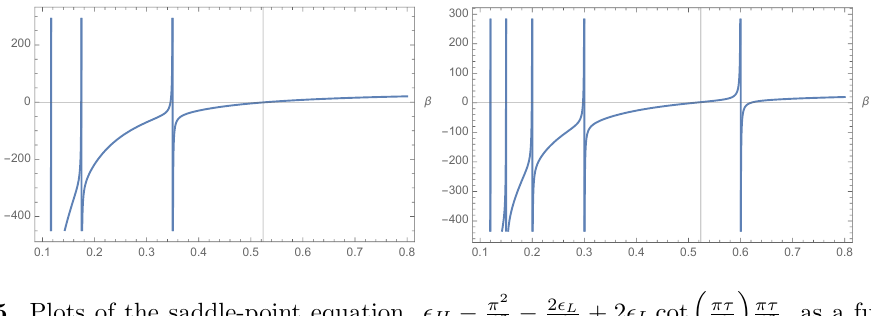
= 36. Left: for (cid:28) < (cid:12) thermal ( E